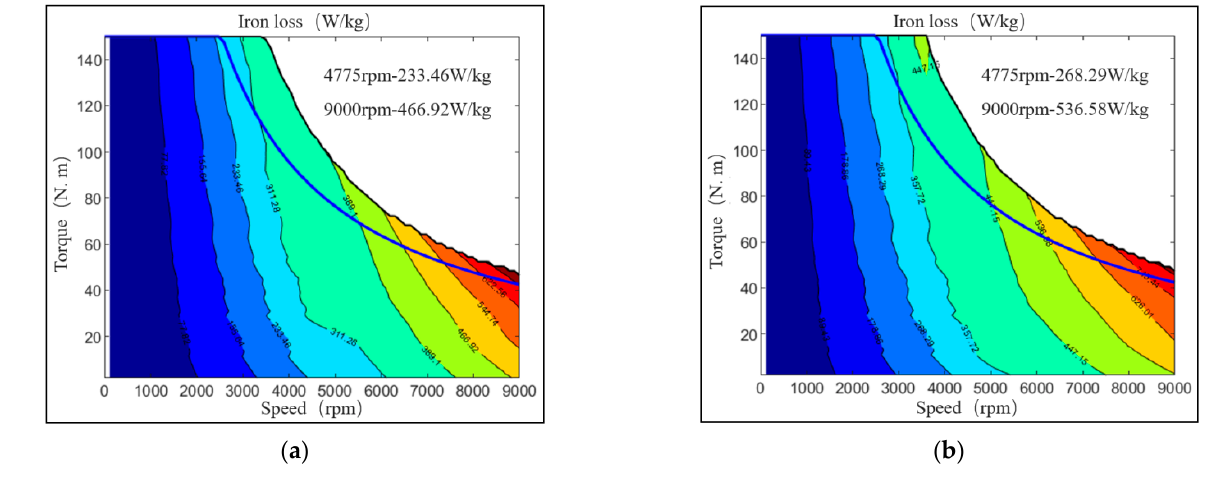
Figure 7. Comparison of motor’s iron loss map. ( a ) Iron loss of SPF; ( b ) iron loss of MPF.